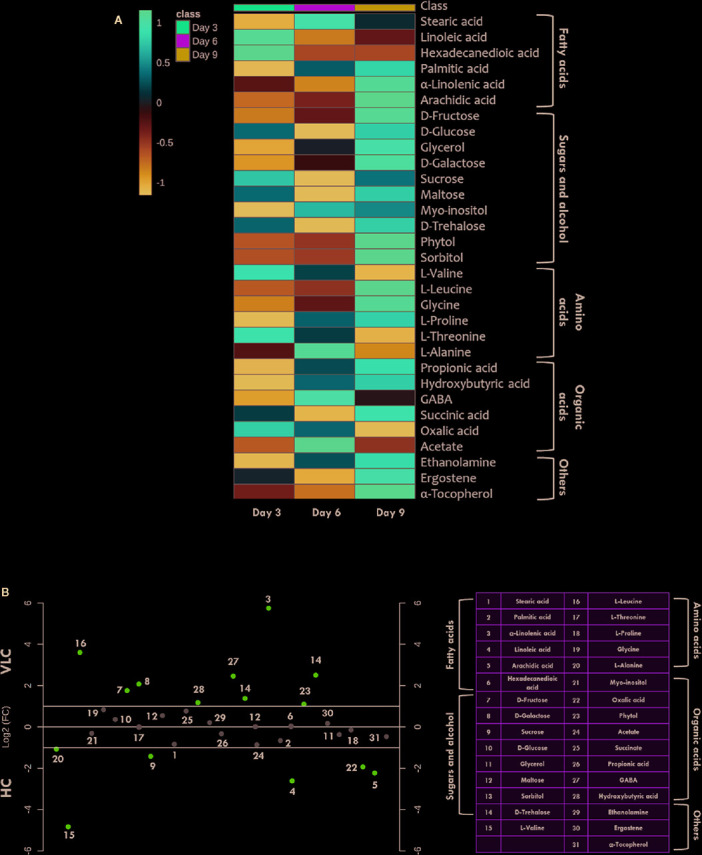
Time-course metabolome dynamics in M. gaditana under VLC/HC. (A) Heatmap represents the log2 fold change of all metabolites (represents time-course, i.e., 3, 6, and 9 days) in VLC/HC. (B) Dot-plot representing the fold-change of different metabolites in VLC and HC supplementation on 9th day in M. gaditana (pink dots represent the metabolites which show fold change >2; gray dots represent the metabolites fold change < 2).